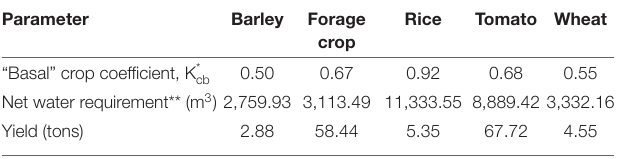
TABLE 2 | WEAP calibration parameters. Parameter Barley Forage